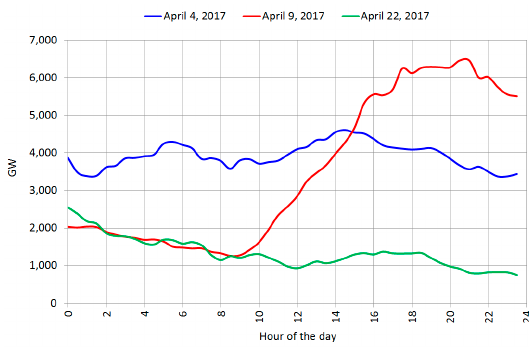
Figure 17. Wind power generated on three consecutive days in the UK. Data retrieved from [61].